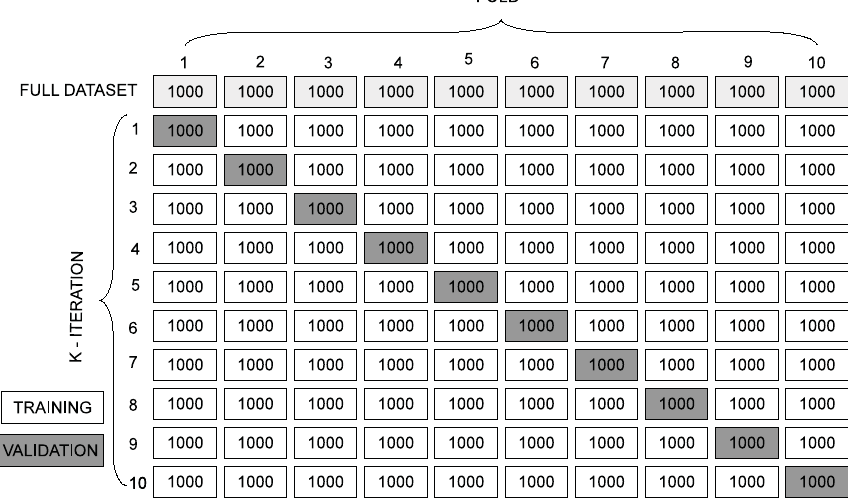
Figure 6. 10-Fold Cross Validation scheme with 10,000 cases.